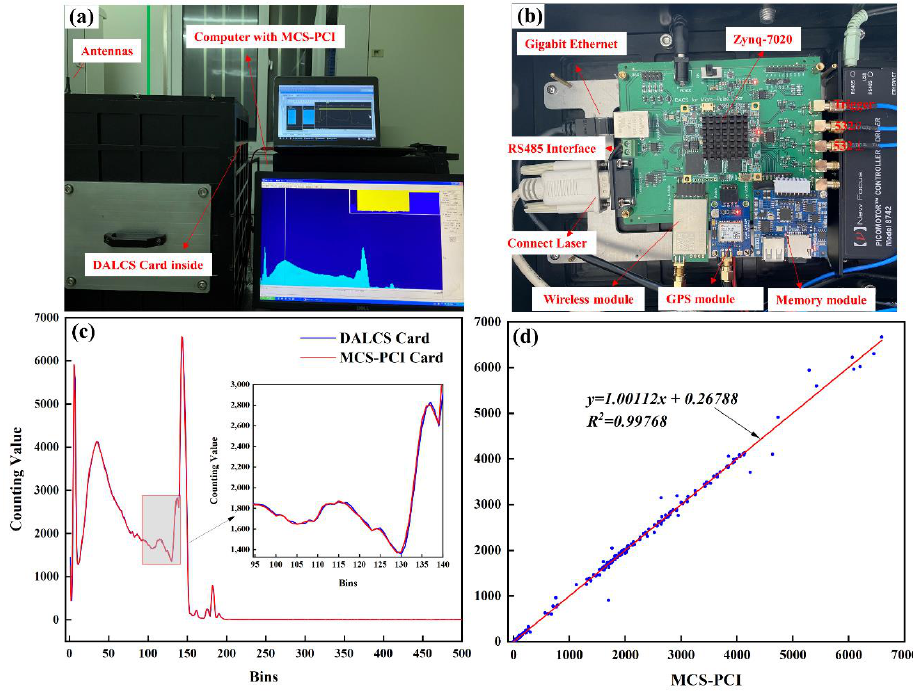
Figure 12. Actual test: ( a ) Lidar test platform; ( b ) DALCS Card; ( c ) comparison of D ALCS and MCS-PCI; ( d ) linear fitting of DALCS and MCS-PCI.